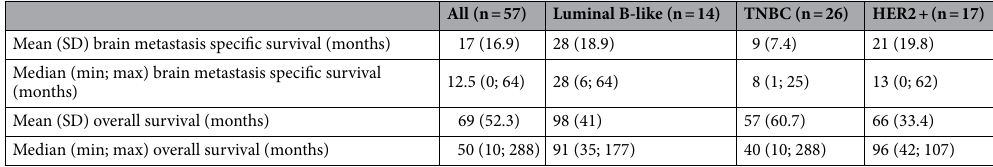
Table 3. TP53 and PIK3CA mutations in primary breast cancer tumors and brain metastases with NGS results fulfilling sequencing quality criteria. The bottom row shows the concordance in mutation status in the 37 matched brain metastasis and primary breast tumors.